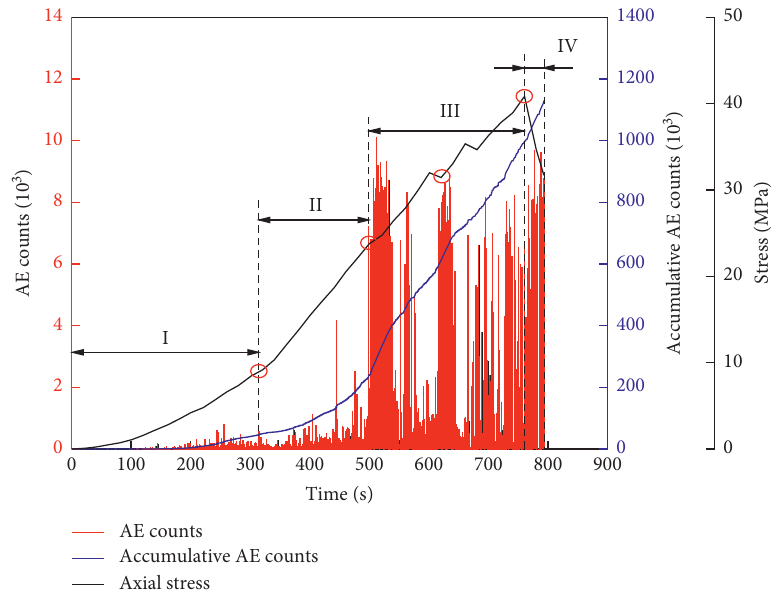
Figure 9: AE counts and accumulative AE counts of the jointed specimens with α � 30 ° .